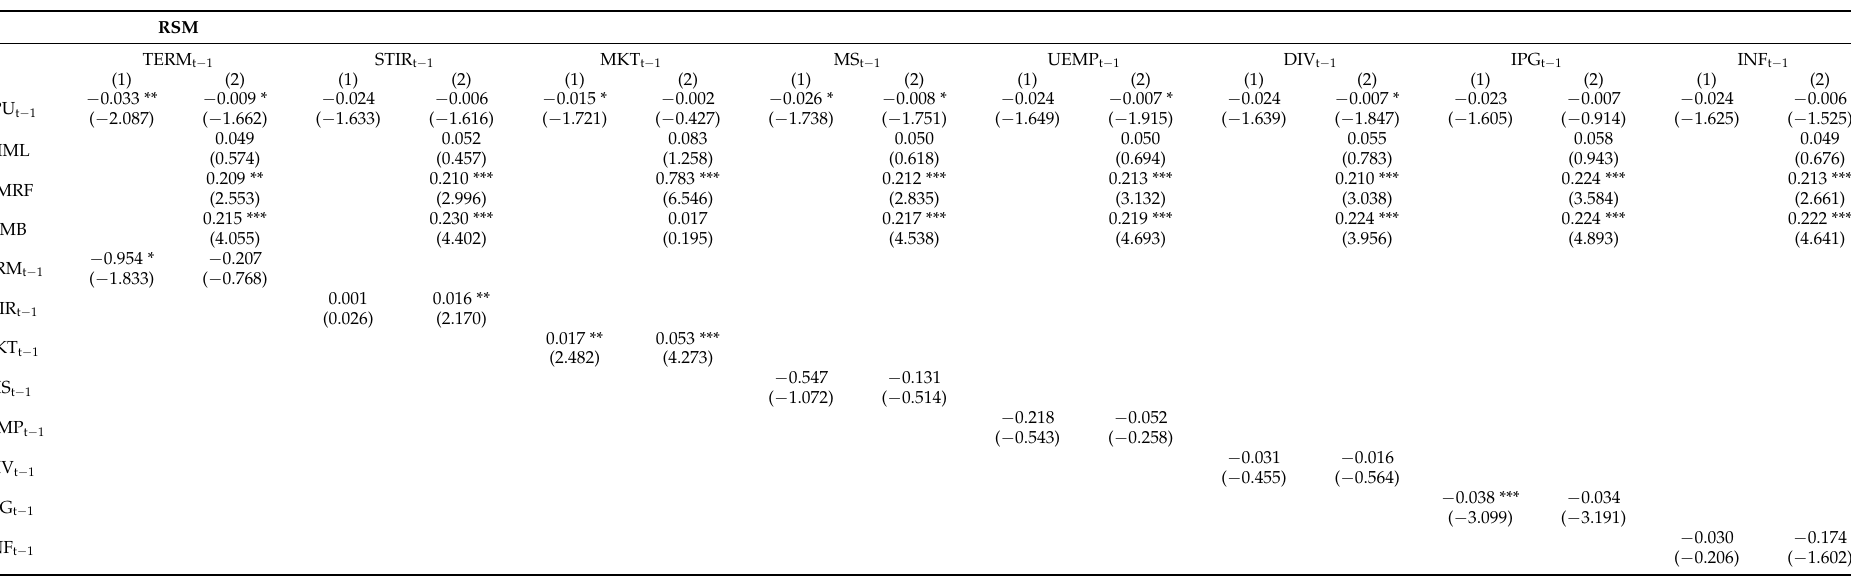
Table 10. Effect of EPU level on return signal momentum strategy return in the Chinese stock market, controlling each of the macroeconomic factors. *** denotes significant at 0.01 level, ** denotes 0.05 significance level, and * represents significant at 0.1 level,